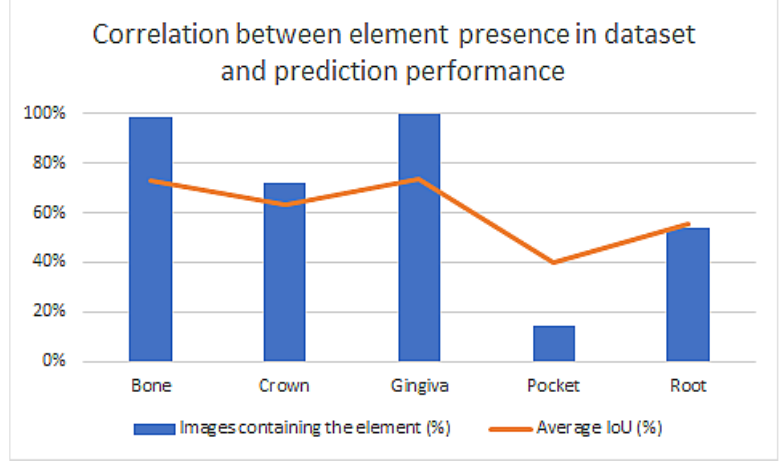
Figure 17. The correlation between the number of element presence in dataset and the prediction accuracy.